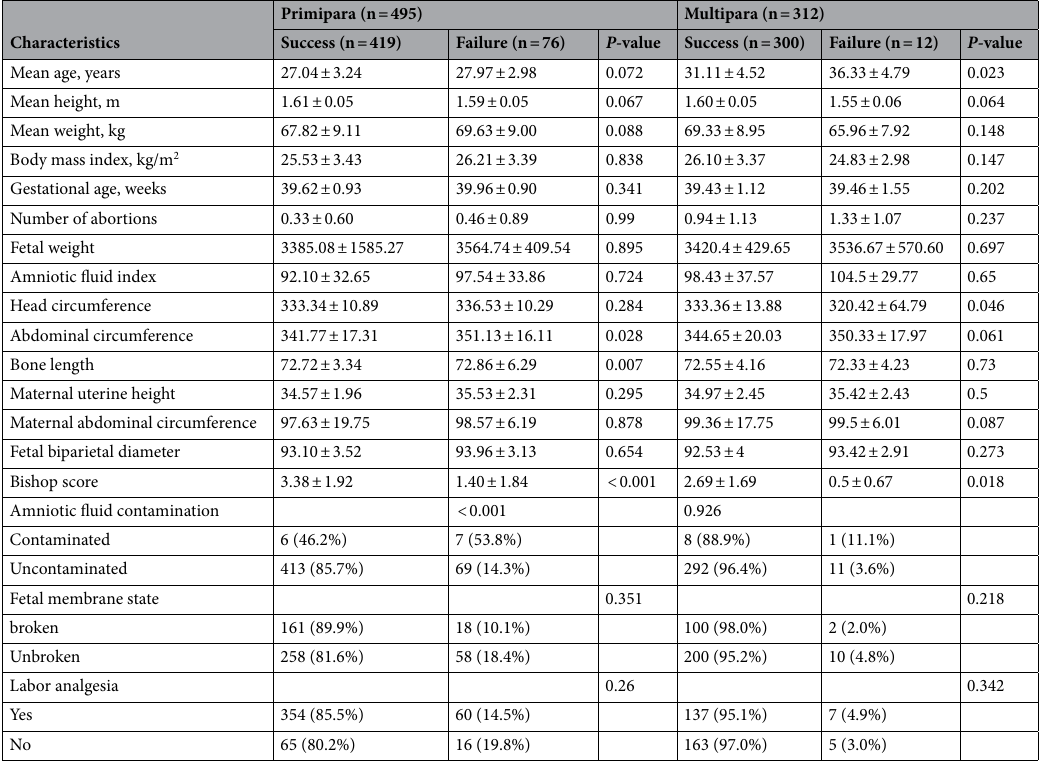
Table 1. Maternal characteristics among induction of labor.